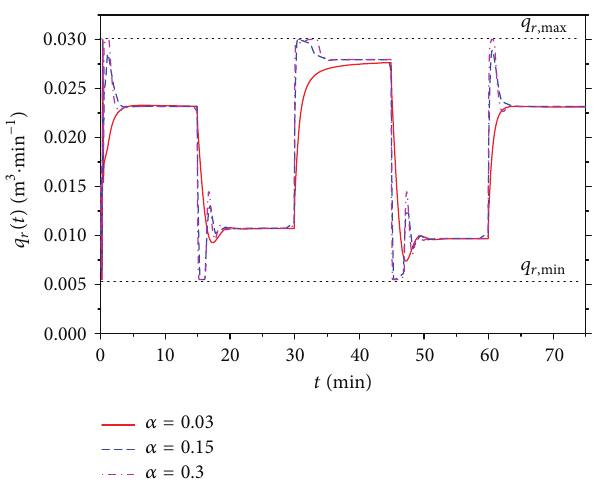
Figure 16: The courses of the computed input variable, 𝑞 𝑟 , to the ELM for various 𝛼 for classic adaptive control.